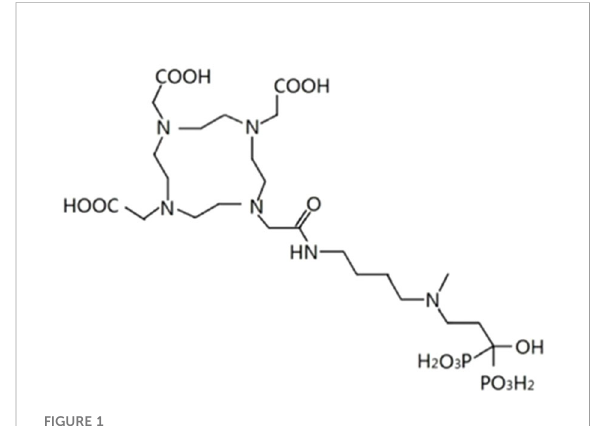
FIGURE 1 The chemical structure of the